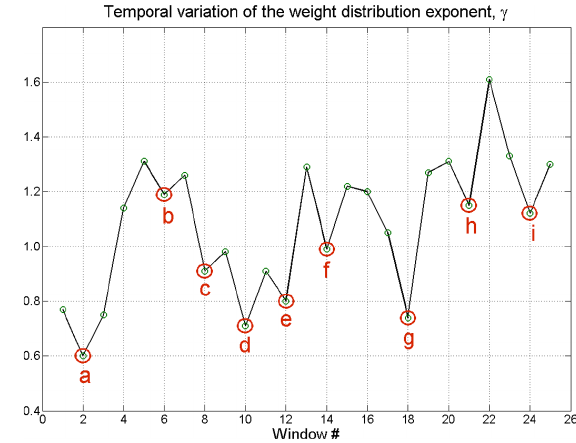
Fig. 13. Temporal variation of the weight distribution exponent (ab- solute value) in successive temporal windows of network